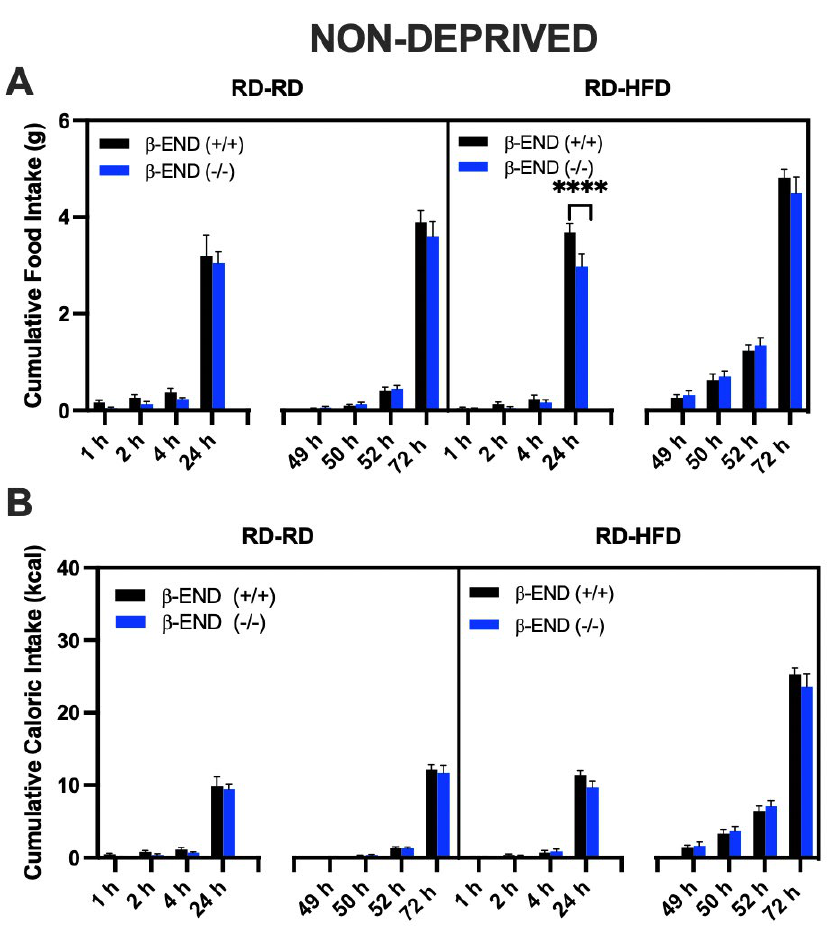
Figure 3. Cumulative ( A ) Food and ( B ) Caloric Intake of non-deprived beta-endorphin knockout mice and their wildtype littermates/controls (n = 6 per group). After baseline (day 2), food measurements were taken (at 1, 2, 4, and 24 h); all animals were maintained on RD for the next 24 h (day 2), then randomly assigned to receive HFD or RD for 24 h (day 3). Food and caloric intake were measured and recorded. All data are expressed as mean ± SEM. **** p < 0.01 by three-way ANOVA/Fisher’s LSD post hoc test.